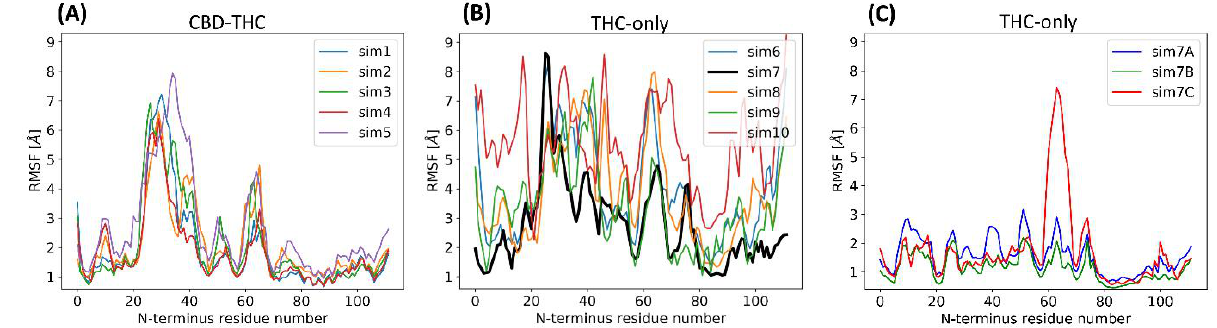
Figure 9. RMSF plots of CB 1 R N-terminus (residues 1–113) measured during 1 µ s long MD simulations starting from the same receptor structure (Figure 4A) bound with ( A ) CBD and THC; ( B ) THC-only; ( C ) for simulations from N-terminus stability corroboration (Table 1). The last 1 µs from 3 µs MD simulations were taken for RMSF calculations.